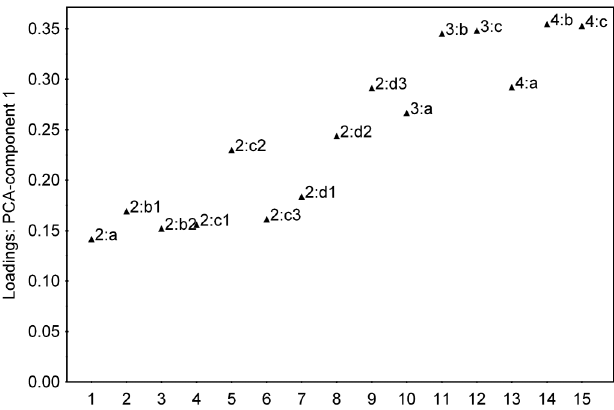
FIG. 3. PCA base model of lab score showing questions with increasing complexity, using one significant component ( y axis). The x axis indicates item index only and does not carry any further information about the data